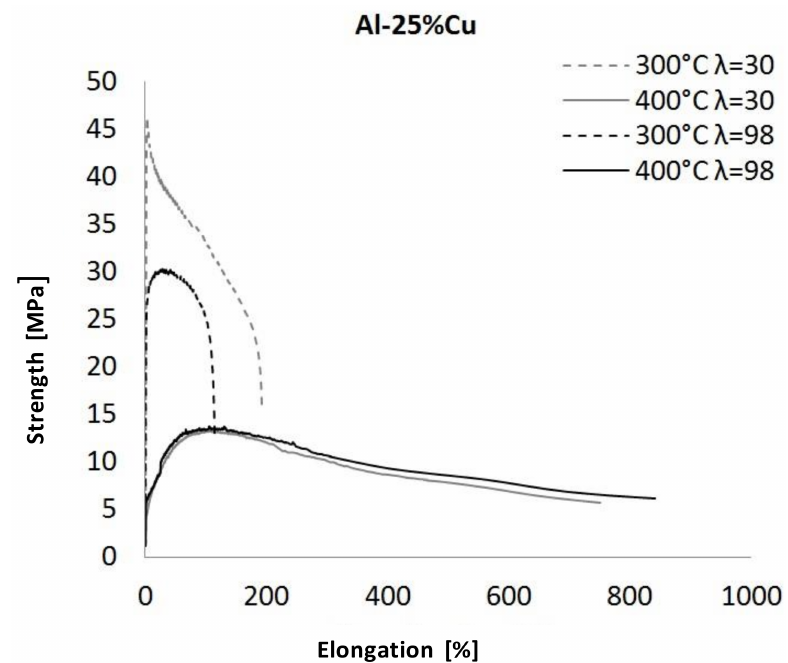
Figure 7. The superplastic tensile stress–strain curves for Al 25 Cu alloy.